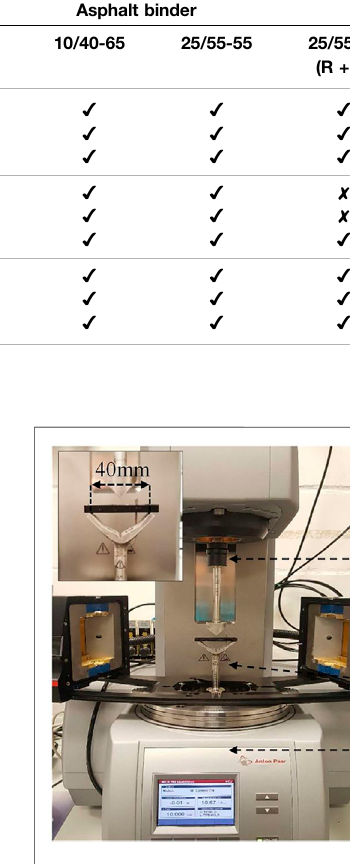
FIGURE 1 | DSR instrument of the type MCR 702 MultiDrive Rheometer (Anton Paar) used for Three-Point Bending